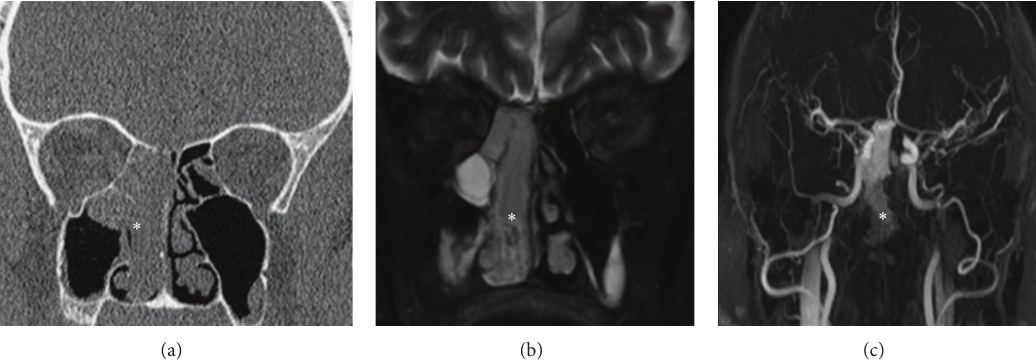
Figure 2: Radiologic findings of sinonasal hemangiopericytoma. CT scan (a), MRI scan (b), and MRI angiography (c). A circumscribed, submucosal,heterogeneoussoft-tissuemassmeasuring5 × 2.4 × 4.5 cminvolvingtherightdorsalnasalcavity,therightethmoid,andsphenoid sinus as well as the nasopharynx. A strong enhancement was seen after intravenous contrast administration ( ∗ tumor).